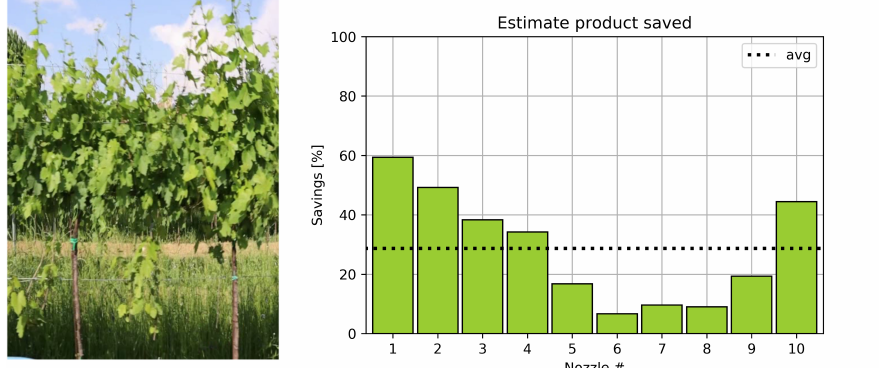
Figure 18. Opening/closing average times of each nozzle evaluated on video sequence captured in June and a sample of the relative